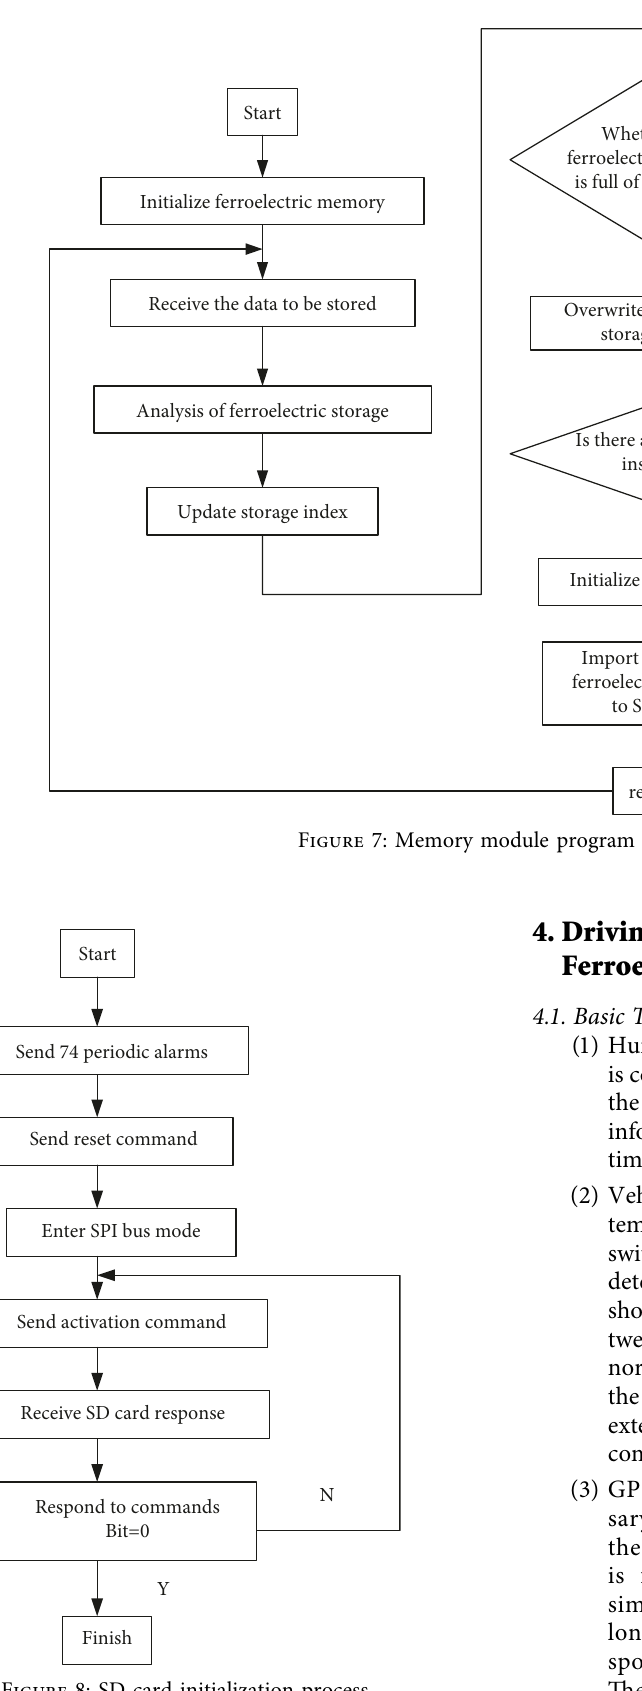
Figure 8: SD card initialization